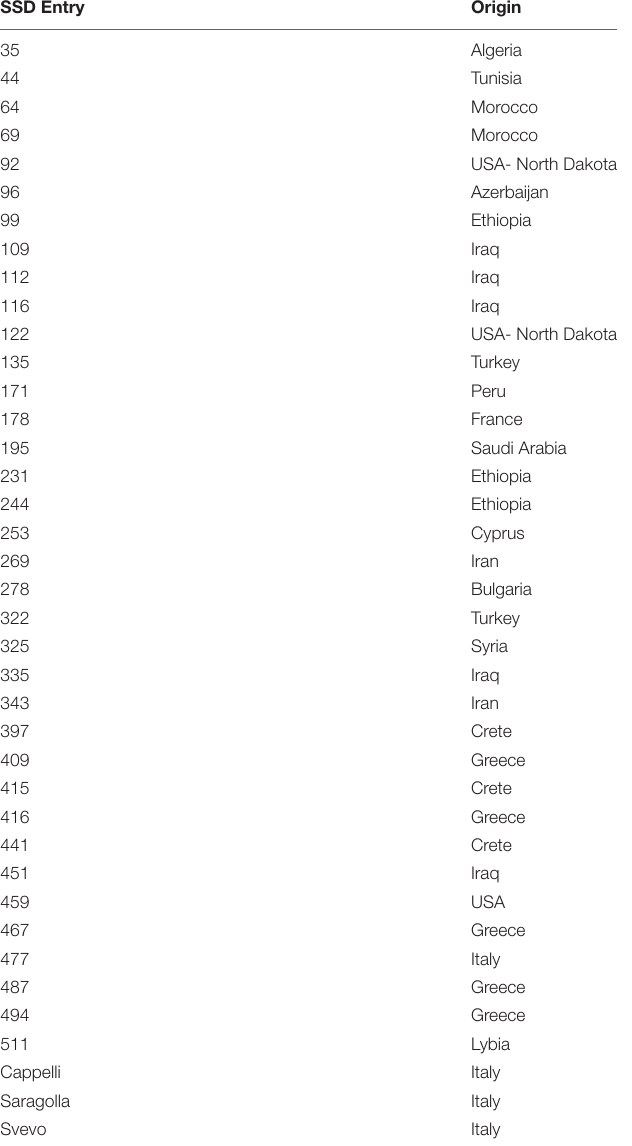
TABLE 1 | SSD entry names and origins of the durum wheat genotypes used in the study. SSD Entry